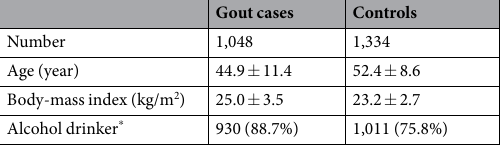
Table 1. Clinical characteristics of participants. Plus-minus values are means ± SD. * Participants who consumed alcohol at least once a month were classified as drinkers.